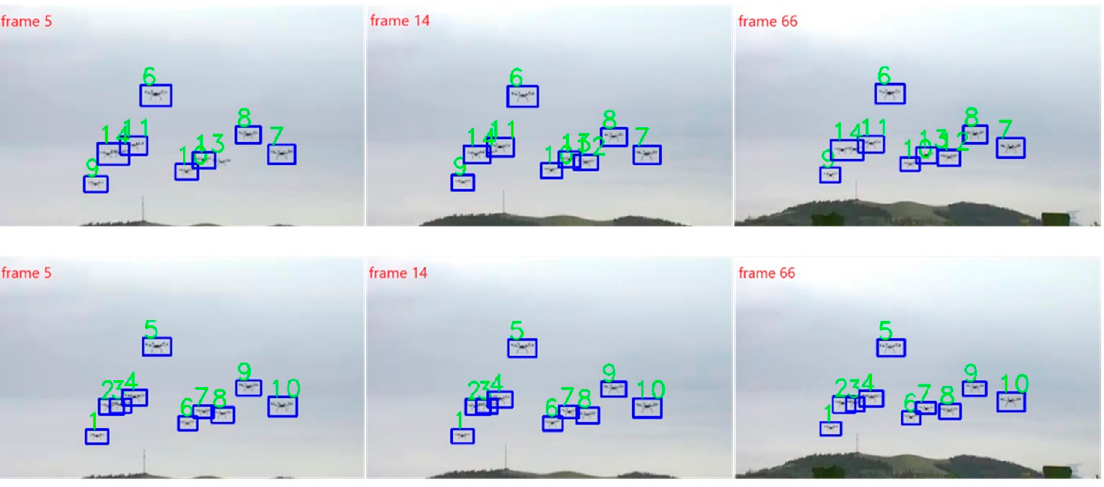
Figure 9. Tracking results of UAVSwarm − 06 (Top: ByteTrack; Bottom: GNMOT; 5th, 14th, and 66th frames, from left to right).